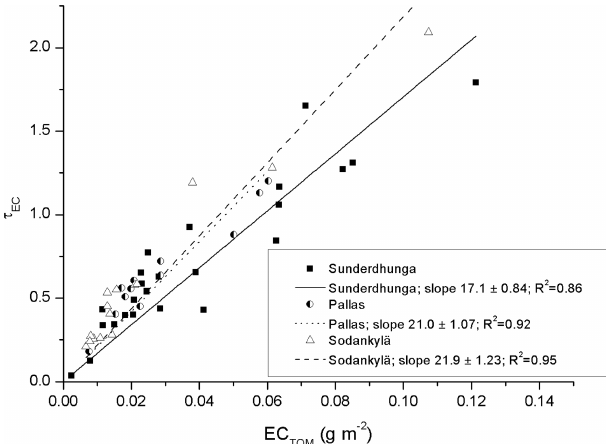
Figure 7. The optical depth τ EC as function of the analyzed EC based on TOM, for the Arctic and Himalayan